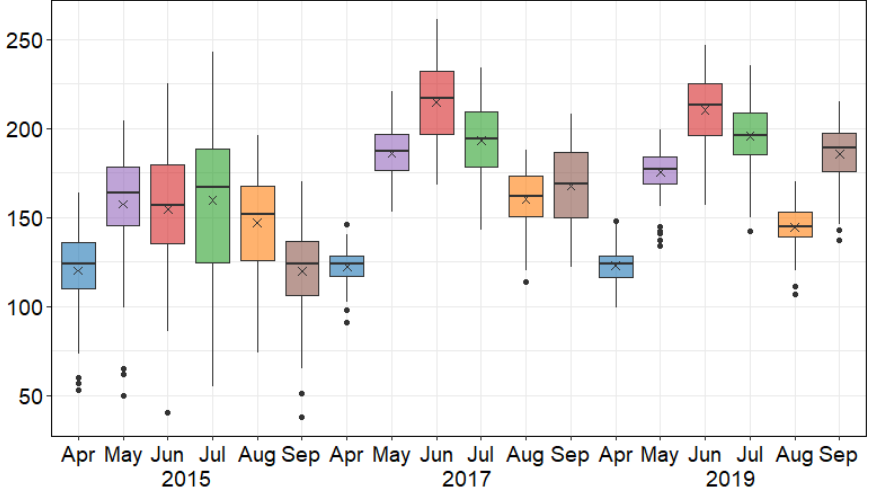
Figure 2. The boxplots of thresholds of stations in BTH Region. The vertical axis is the value of the threshold (µgm − 3 ). The bold line and cross in each box represent the mean and median, respectively. The lines above and below the box show the extreme values, while the points are